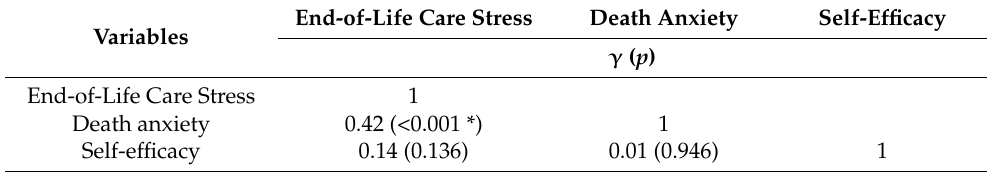
Table 4. Correlations of terminal care stress, anxiety about death, and